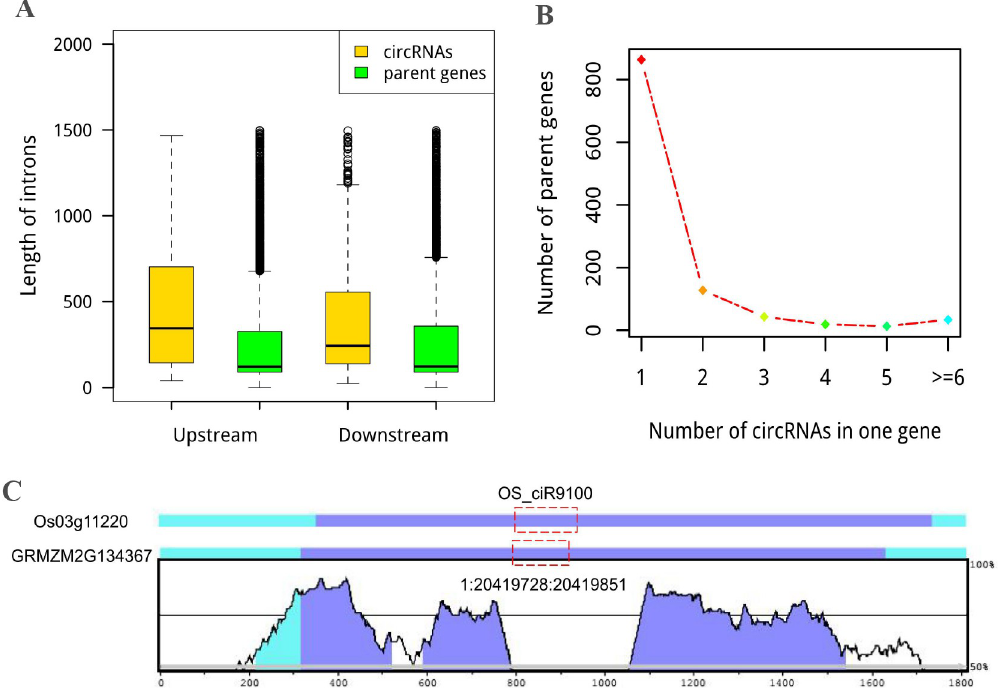
Fig 2. The genomic character and conservation of circRNAs. (A) Mean length distribution of upstream and downstream intron flanking circularized exons in Z . mays . Longer intron bracketing circularized exons was observed than the parent gene. (B) The number of genes (y-axis) that generated different numbers of circRNAs (x-axis). (C) An example of sequence conservation analysis of circRNAs between O . sativa and Z . mays . Y-axis, levels of conservation based on genomic sequence similarity. The locations of circRNAs in their respective parent genes are marked with a red box. Conserved regions are labelled in different colours by VISTA according to the annotations (exons in blue shadow, UTR in cyan shadow and CNS (non-coding sequences) in red